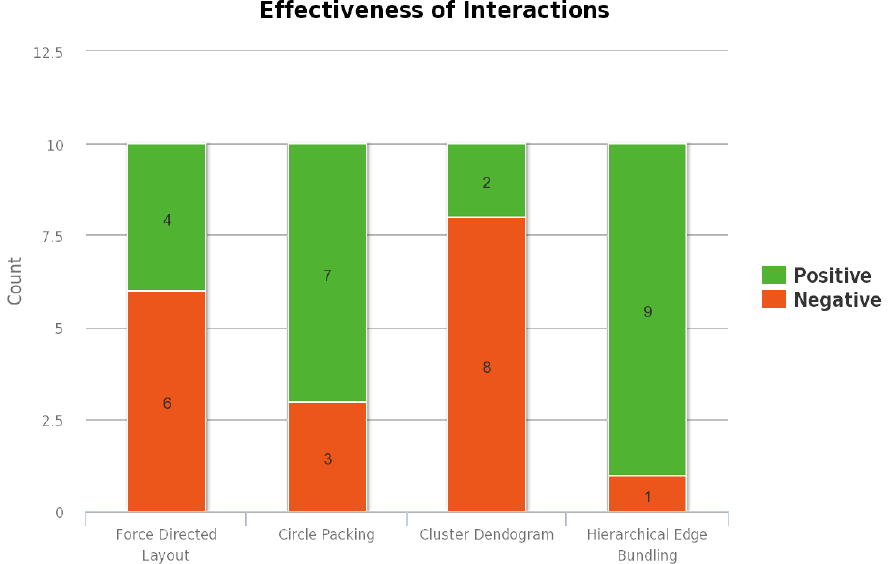
Figure 3. Stacked bar chart representing the distribution of effectiveness for all the interactions